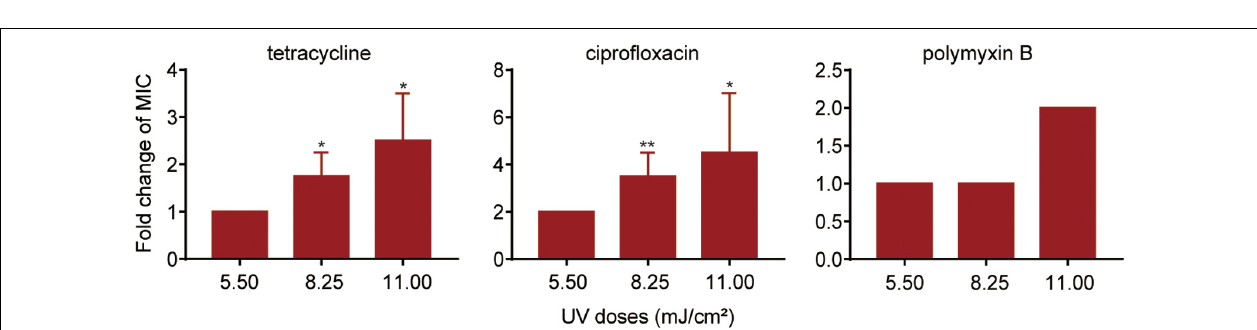
FIGURE 1 | Percentage of killed bacteria following UV exposure. The baseline conditions were as follows: the initial concentration of P. aeruginosa was ∼ 10 9 CFU/mL (pH 7.2, 20 ◦ C). Data are shown as the mean ± standard deviation (s.d.). (n = 3).